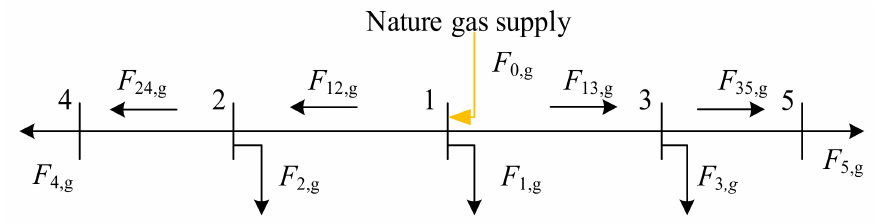
Figure 5. Natural gas network topology with energy